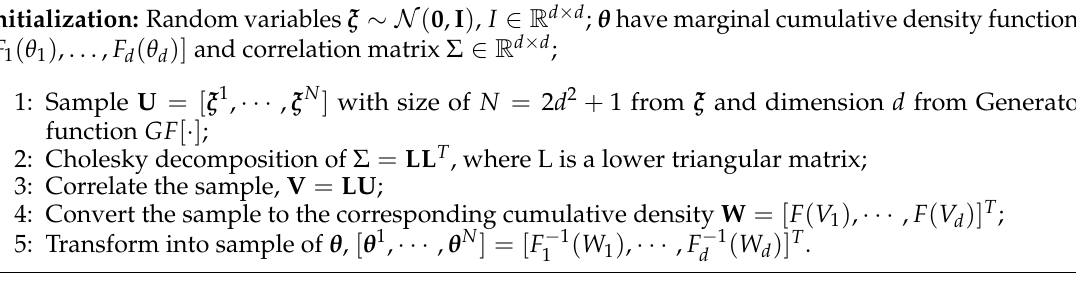
Algorithm 1 Sampling for correlated random